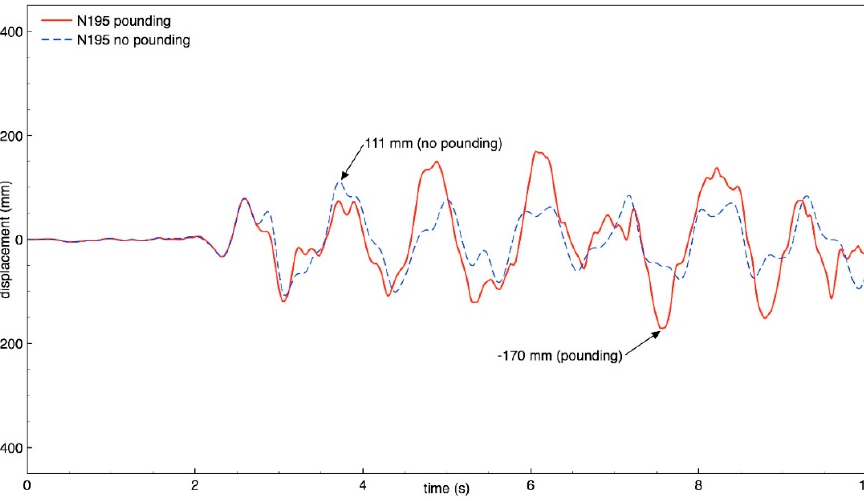
Figure 20. Transverse response of building A (node N195) with and without pounding.